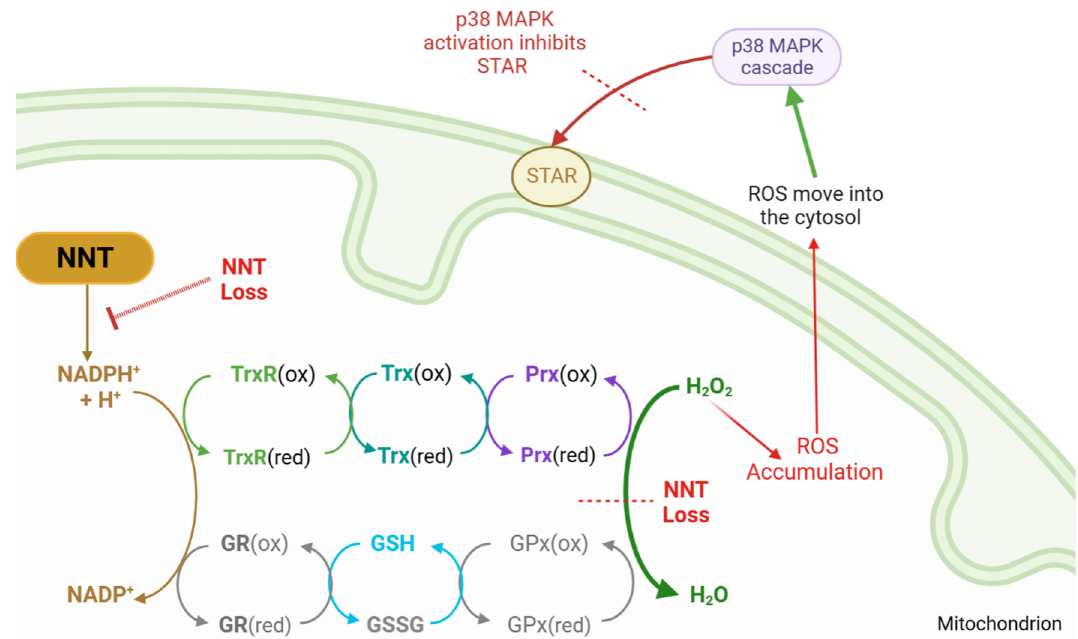
Figure 2. PRDX3 steroidogenesis feedback loop, outlining reduction–oxidation reactions that detoxify reactive oxygen species (ROS). Nicotinamide nucleotide transhydrogenase (NNT) supplies the reductive power for the glutathione (GSH/GSSG) and thioredoxin (Trx) systems to detoxify hydrogen peroxide (H 2 O 2 ). With NNT loss, ROS accumulates and leaks into the cytosol, where it activates the p38 MAPK cascade, inhibiting STAR function and reducing cholesterol transfer. NNT = nicotinamide nucleotide transhydrogenase, NADP = nicotinamide adenine dinucleotide phosphate, NADPH = reduced NADP, MAPK = mitogen ‐ activated protein kinase, STAR = steroidogenic acute regulatory protein, GSH = reduced glutathione, GSSG = glutathione disulphide, GR = glutathione reductase, GPx = glutathione peroxidase, Trx = thioredoxin, TrxR = thioredoxin reductase, Prx = peroxiredoxin, (ox) = oxidated state, (red) = reduced state.